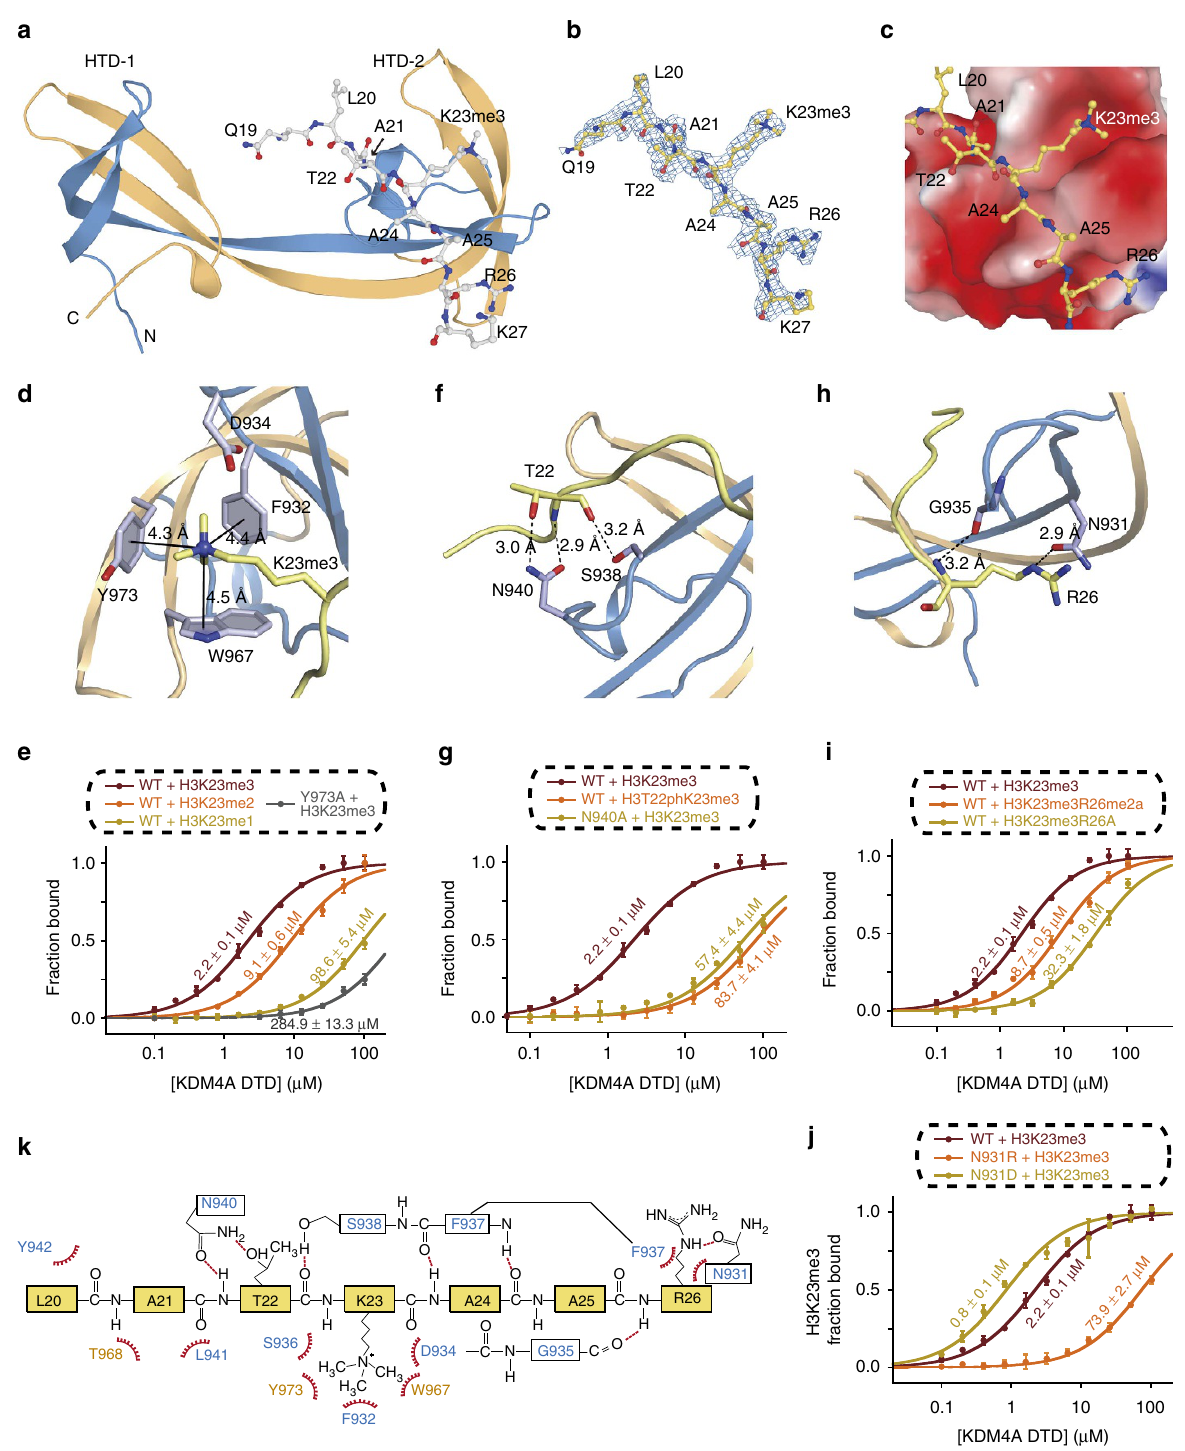
Figure 2 | Co-crystal structure of KDM4A-DTD with H3K23me3. ( a – c ) Co-crystal structure of KDM4A-DTD and H3 (19–27) K23me3 peptide at 2.28Å resolution (PDB ID: 5D6Y). Data collection and refinement statistics are summarized in Table 1. ( d – j ) Biochemical validation of intermolecular interactions observed in KDM4A-H3K23me3 structure. Aromatic cage ( d , e ), H3T22-N940 pair ( f , g ) and H3R26–N931 pair ( h – j ) contribute to KDM4A-H3K23 recognition. Binding affinity of corresponding protein-peptide combinations is quantified by fluorescence polarization assays. Errors represent s.d. from three experimental replicates. See Supplementary Table 1 for peptide information. ( k ) Schematic representation of the molecular interactions between KDM4A-DTD and H3(20–26)K23me3 peptide as identified in the co-crystal structure (PDB ID: 5D6Y). Colouring of KDM4A-DTD in a , d , f , h and k corresponds to Fig.